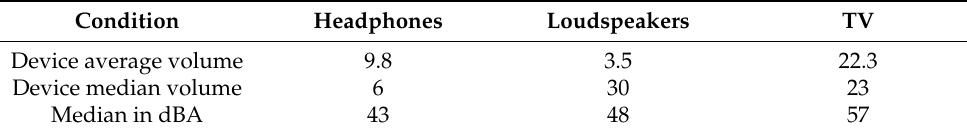
Table 1. Average and media volumes set by the